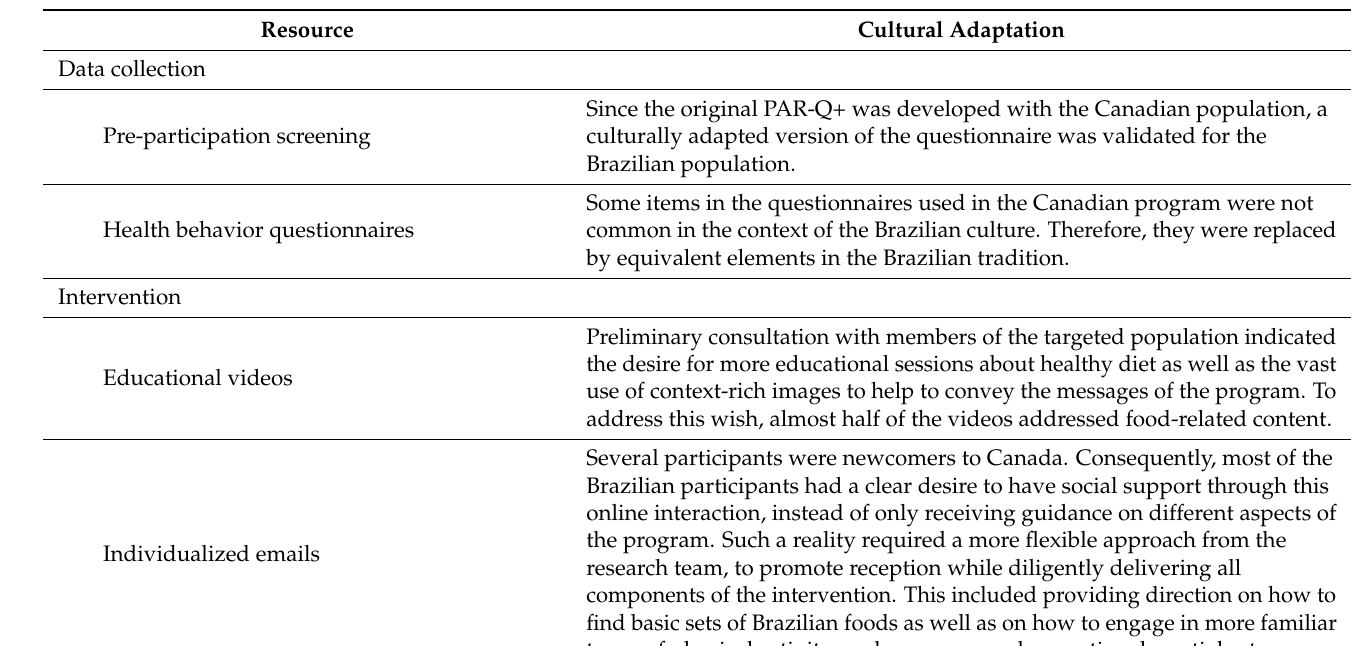
Table 3. Adaptation of resources for data collection and delivery of the